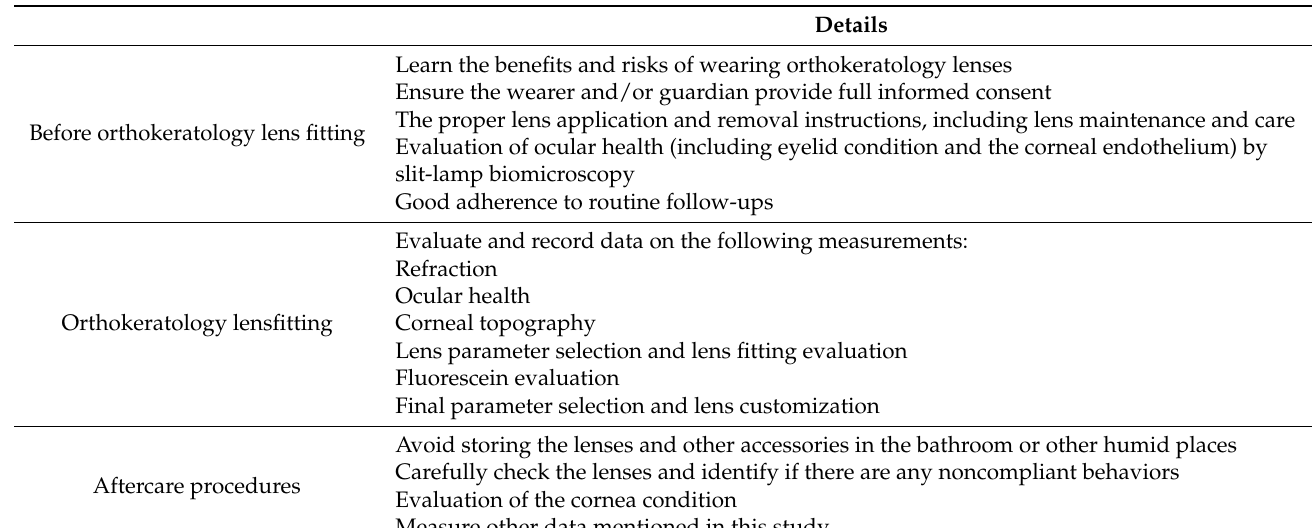
Table 1. Orthokeratology lens fitting and aftercare